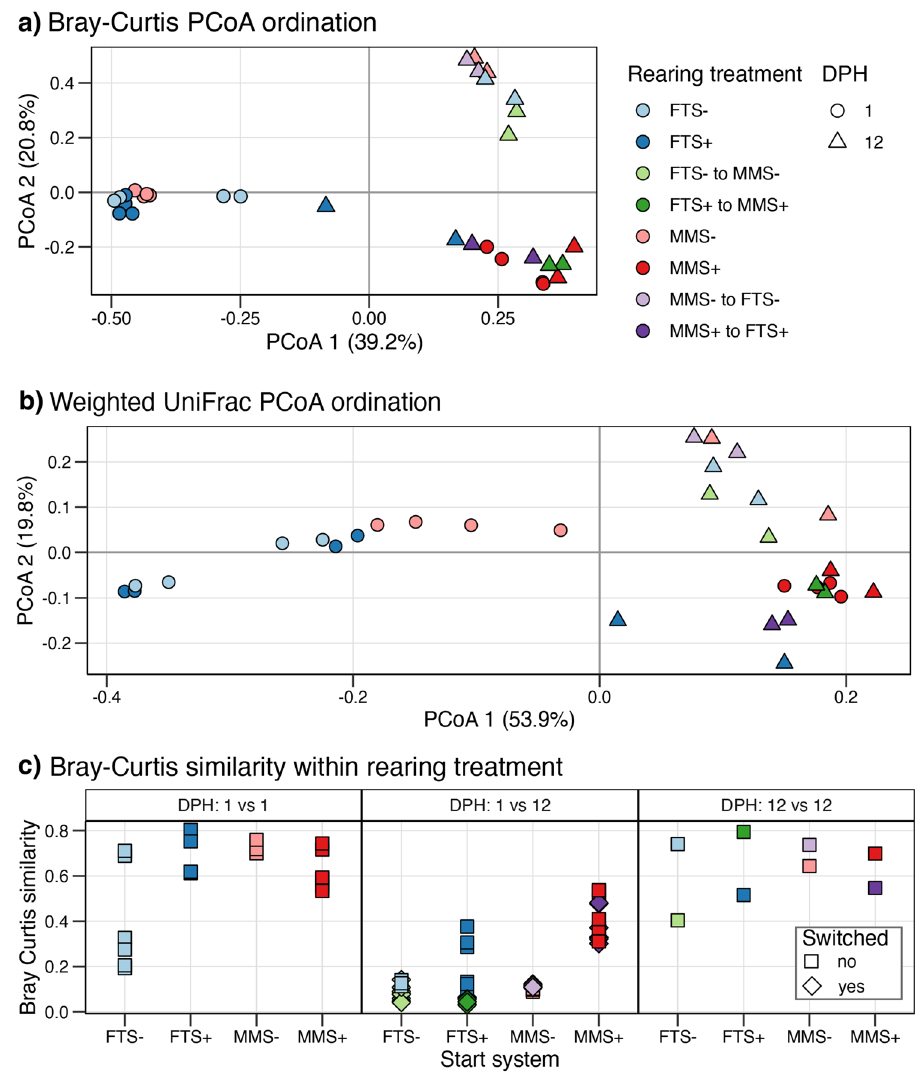
Figure 3. Community composition comparisons between samples (β-diversity) based on rearing treatment. PCoA ordinations are based on ( a ) Bray–Curtis or ( b ) weighted UniFrac distance. Colours indicate rearing treatment, and shape signifies 1 (filled circle) and 12 DPH (filled triangle). ( c ) The Bray–Curtis similarity within rearing treatment within and between sampling days. Colours indicate rearing condition and shape unswitched (filled square) and switched (filled diamond)